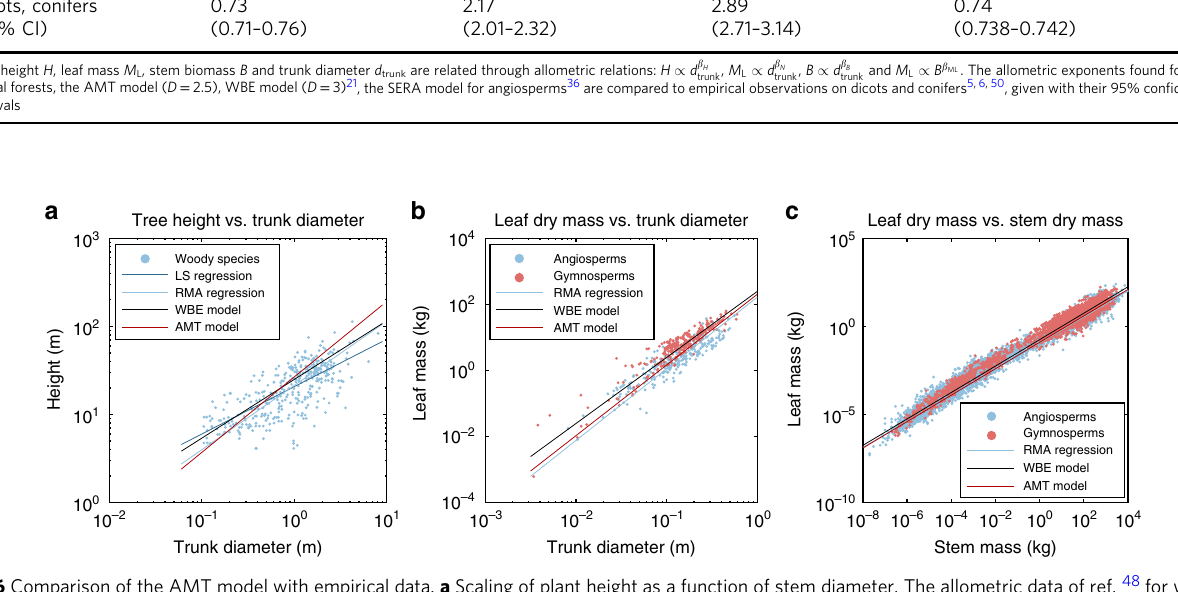
Table 3 Comparison of allometric exponents Virtual forests